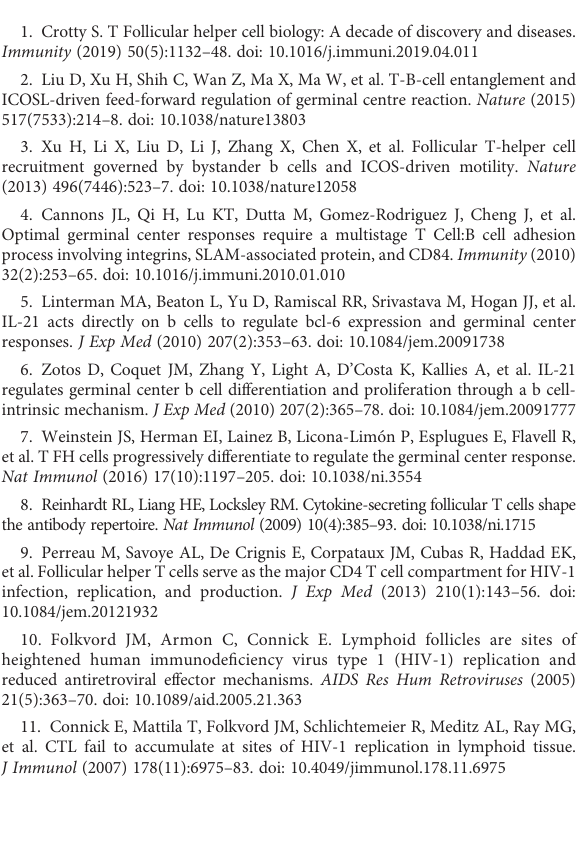
SUPPLEMENTARY FIGURE 8 TFR expression of CD39, GITR, and LAG-3 in absence or presence of IL-2. TFH were spinoculated with CXCR4-tropic HIV, labeled with VPD, and cultured at a 1:1 ratio with unlabeled, uninfected TFR for 5 days with 5 m M saquinavir in the absence or presence of 10, 30, or 100 IU/ml IL-2. Percentages of TFR expressing CD39 (A) , GITR (B) , or LAG-3 (C) were quanti fi ed via fl ow cytometry (n=6). Statistical analyses were performed using Friedman test and Dunn ’ s multiple comparison test using Graphpad Prism v8 and signi fi cance indicated: *p ≤ 0.05, **p ≤